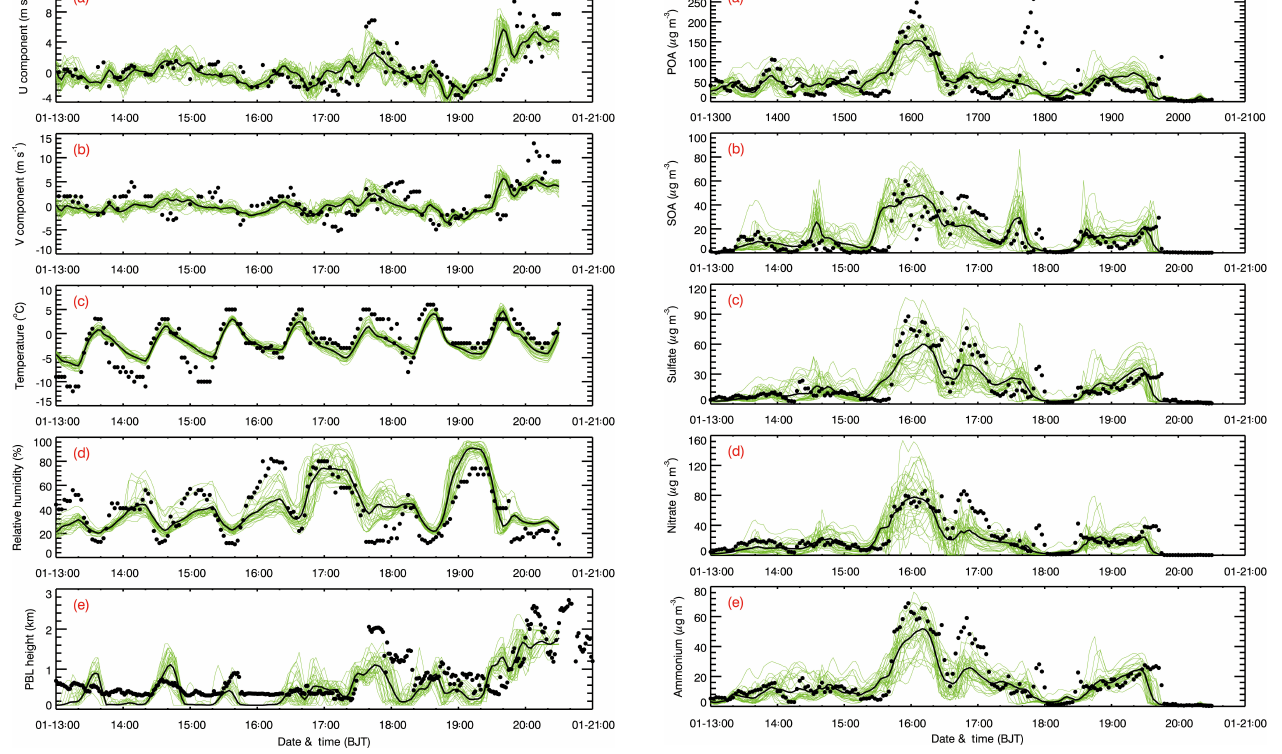
Figure 4. Temporal evolution of the surface (a) U component, (b) V component, (c) temperature, and (d) relative humidity at the mete- orological site, and (e) the PBL height at IRSDE in Beijing from each ensemble member (thin green lines), the ensemble mean (bold black line), and observations (black dots) from 13 to 20 January 2014.